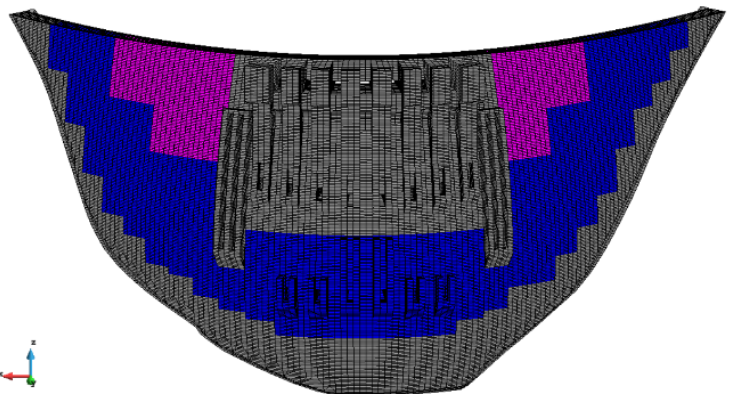
Figure 7. Finite element grid of dam body .